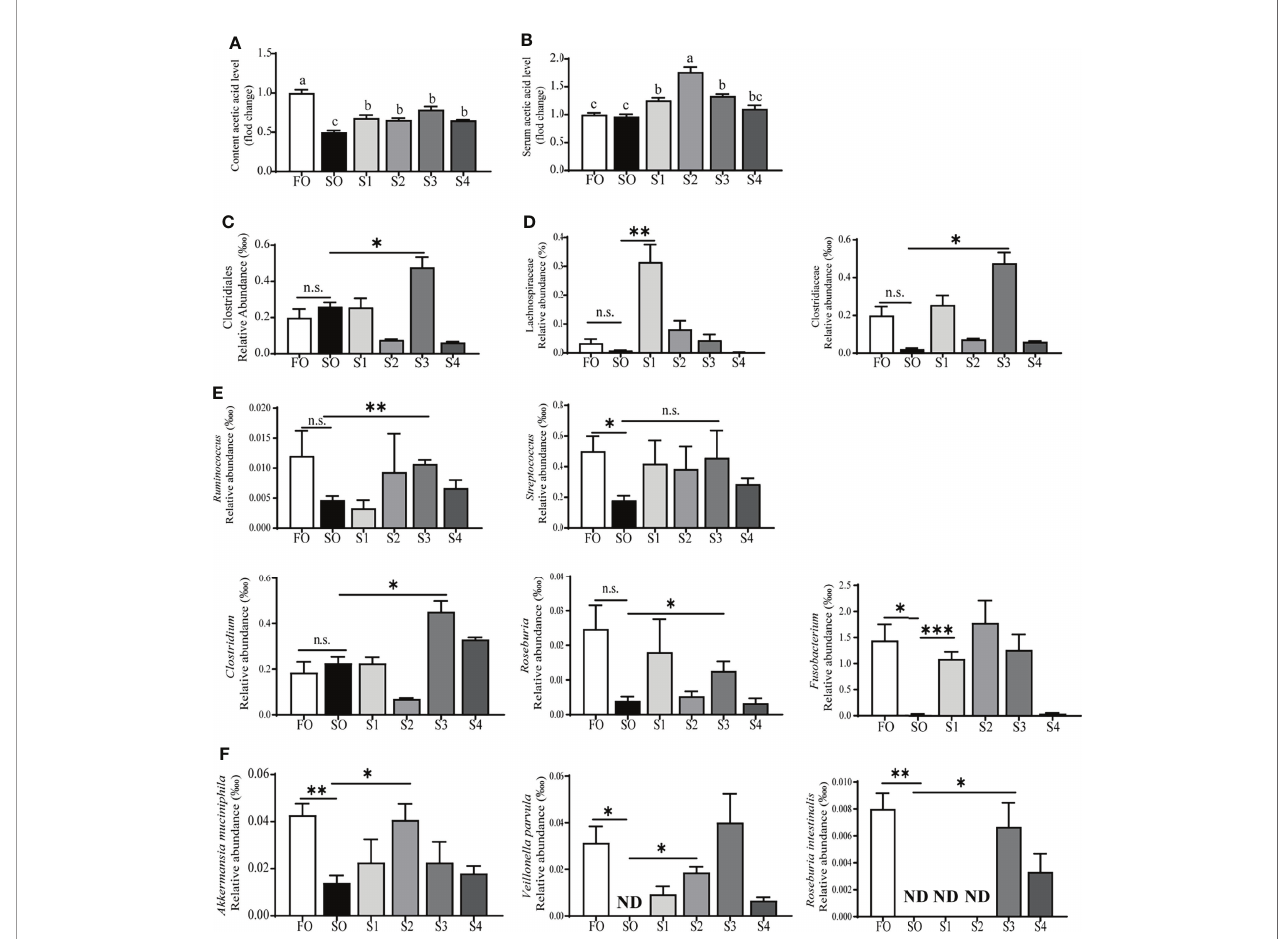
FIGURE 5 | Octanoate supplementation up-regulated acetic acid production. The fold change of acetic acid level in intestinal content (A) , and serum (B) . The relative abundance of acetate-producing strains in content fl ora at the order (C) , family (D) , genus (E) , and species (F) level. ND, Not found in samples. Data of the fold change of acetic acid level were presented as means ± S.E.M. Means in each bar sharing the same superscript letter or absence of superscripts were not signi fi cantly different determined by Tukey ’ s test ( P ≥ 0.05). S.E.M., standard error of means (n = 3). Data of the relative abundance of acetate-producing strains were analyzed using independent t-test (n.s., No signi fi cant; P ≥ 0.05, *0.01 ≤ P < 0.05, ** 0.001 ≤ P < 0.01, *** P < 0.001) (n =